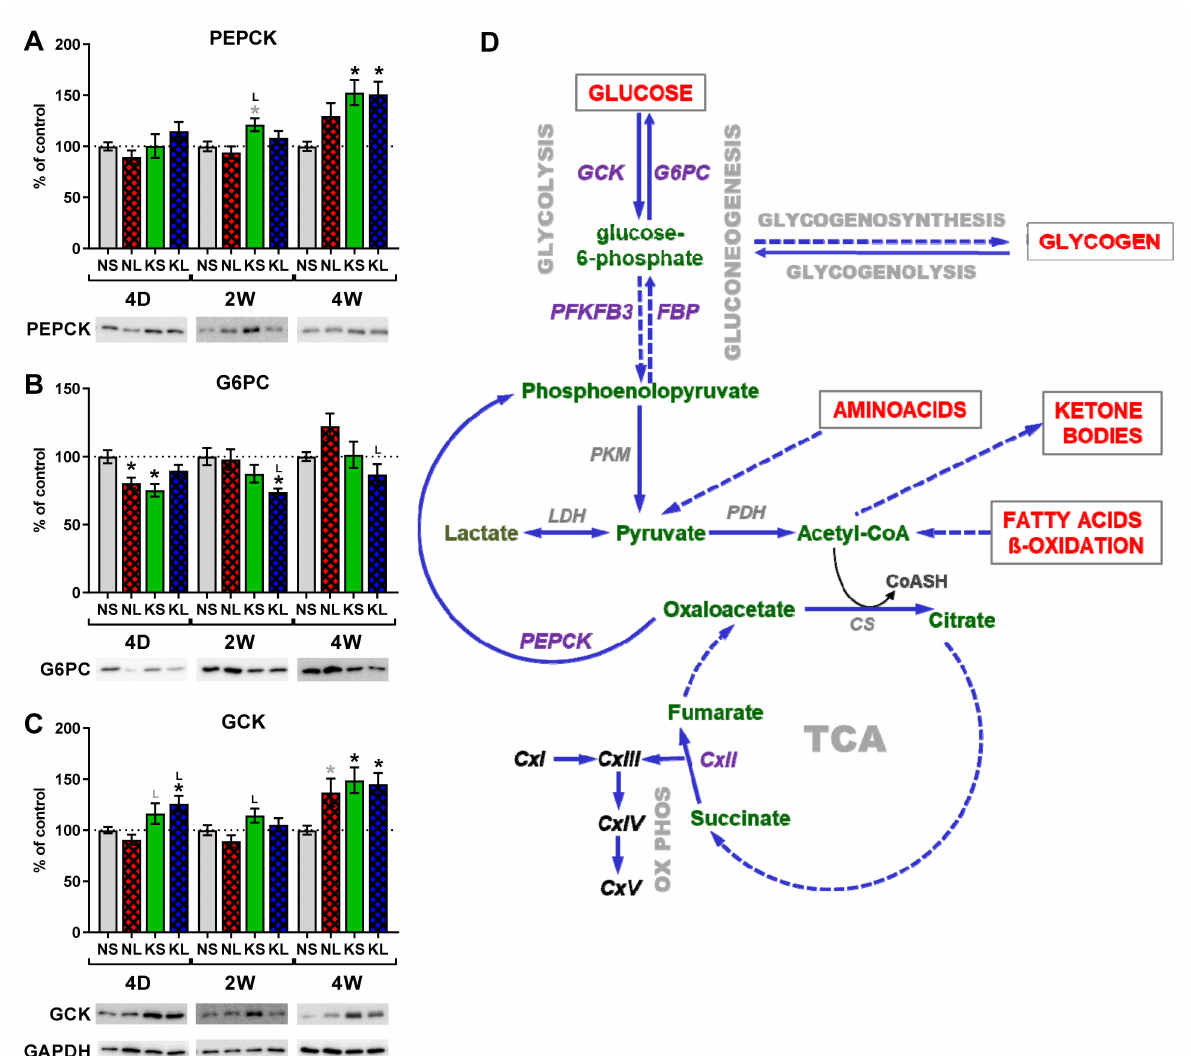
Figure 8. Protein expression in liver, ( A – C ) Western blot and schematics of liver energy metabolism ( D ). Analysis was performed on liver homogenates in triplicate for each animal, from n = 6 animals per group. Data are presented in % of control as mean ± SEM. Analysis was performed at time-points 4 days, 2 weeks, and 4 weeks after brain surgery. Animals were kept on ketogenic diet for 3 weeks in advance. p value ≤ 0.05 was set as significance threshold and marked as * vs. normal diet + sham (NS group), L vs. normal diet + 6-OHDA lesion (NL group), K vs. ketogenic diet + sham (KS group), KL stands for ketogenic diet + 6-OHDA lesion group. Statistical trends 0.05 < p ≤ 0.1 were marked in grey symbols. Statistics: 3-way ANOVA with LSD post hoc test. ( C ) Liver energy metabolism. Full arrows indicate direct processes, while dashed arrows indirect, with additional processes in-between. CS—citrate synthase; FBP—fructose 1,6-bisphosphatase; G6PC—glucose-6-phosphatase; GCK—glucokinase; LDH—lactate dehydrogenase; OxPhos—oxidative phosphorylation; PDH—pyruvate dehydrogenase; PEPCK—phosphoenolpyruvate carboxykinase; PFKFB3—6-phosphofructo-2-kinase/fructose-2,6-biphosphatase 3; PKM—pyruvate kinase; TCA—tricarboxylic acid